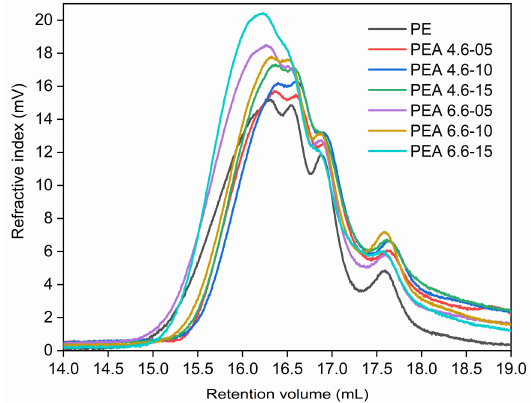
Figure 3. SEC elugrams of the resins synthesized in this